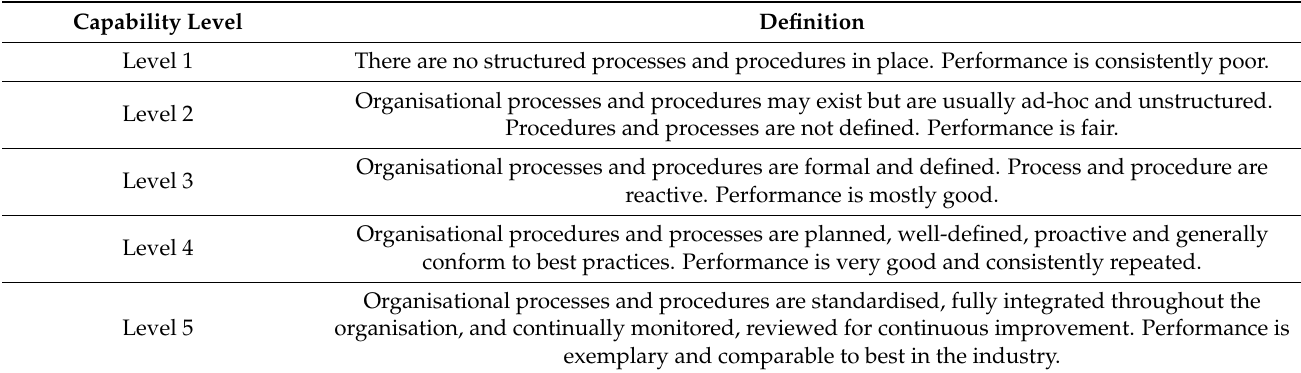
Table 1. Capability maturity levels and